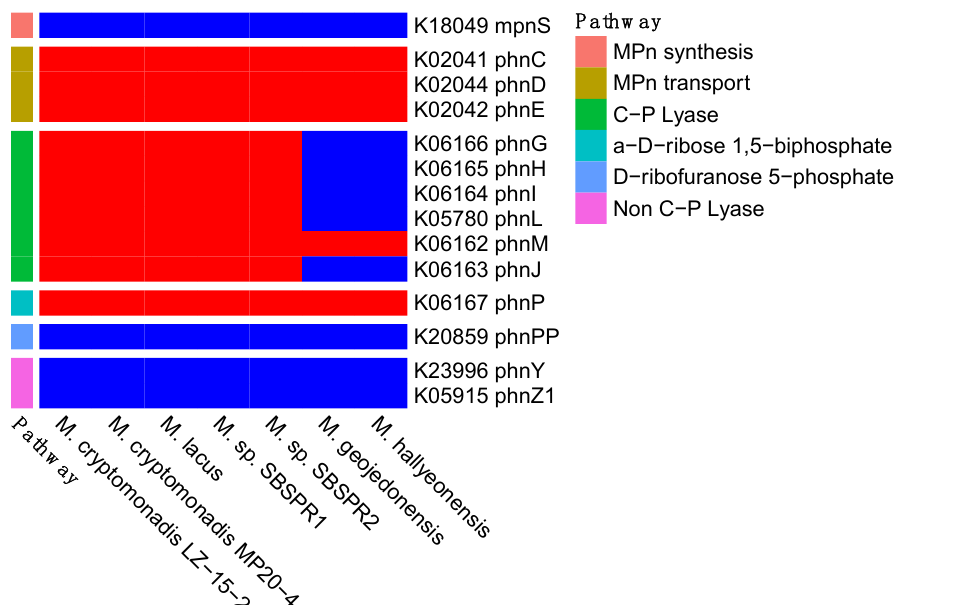
( b ) Marivita ( log 2 counts per million